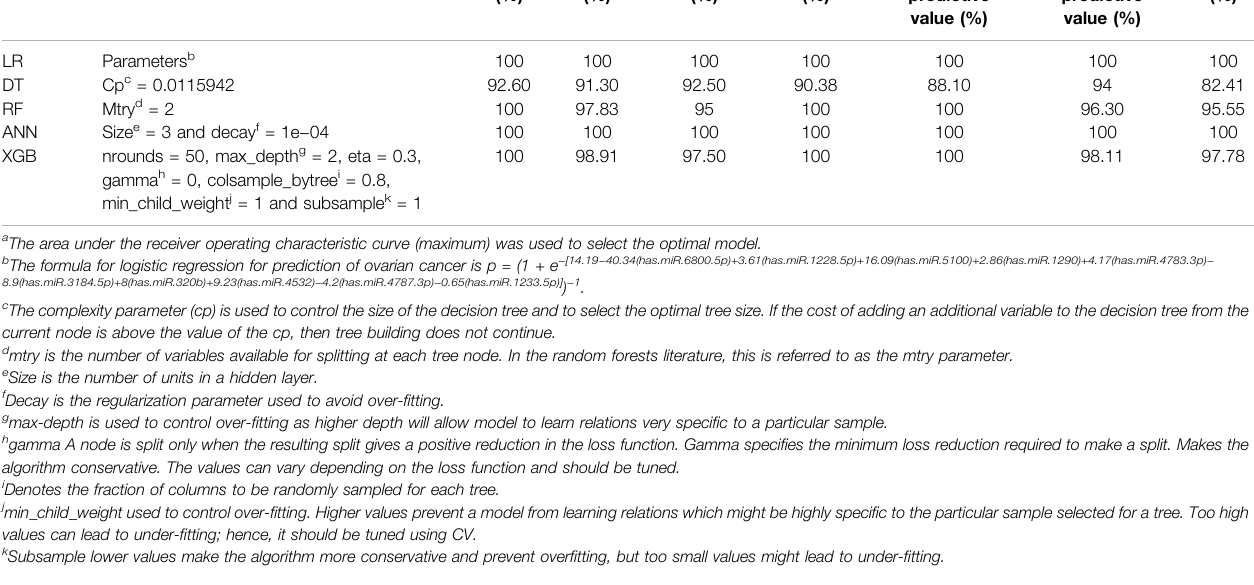
TABLE 3 | Predictive power of models for ovarian cancer classi fi cation and prediction in the external (GSE113486) validation data. Classi fi er